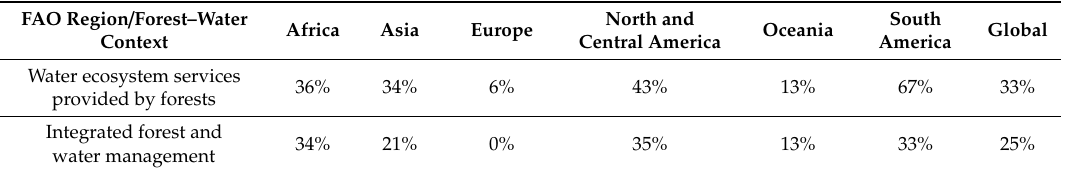
Table 4. Share of (I)NDCs reporting on water-related services provided by forests and integrated forest water management per FAO